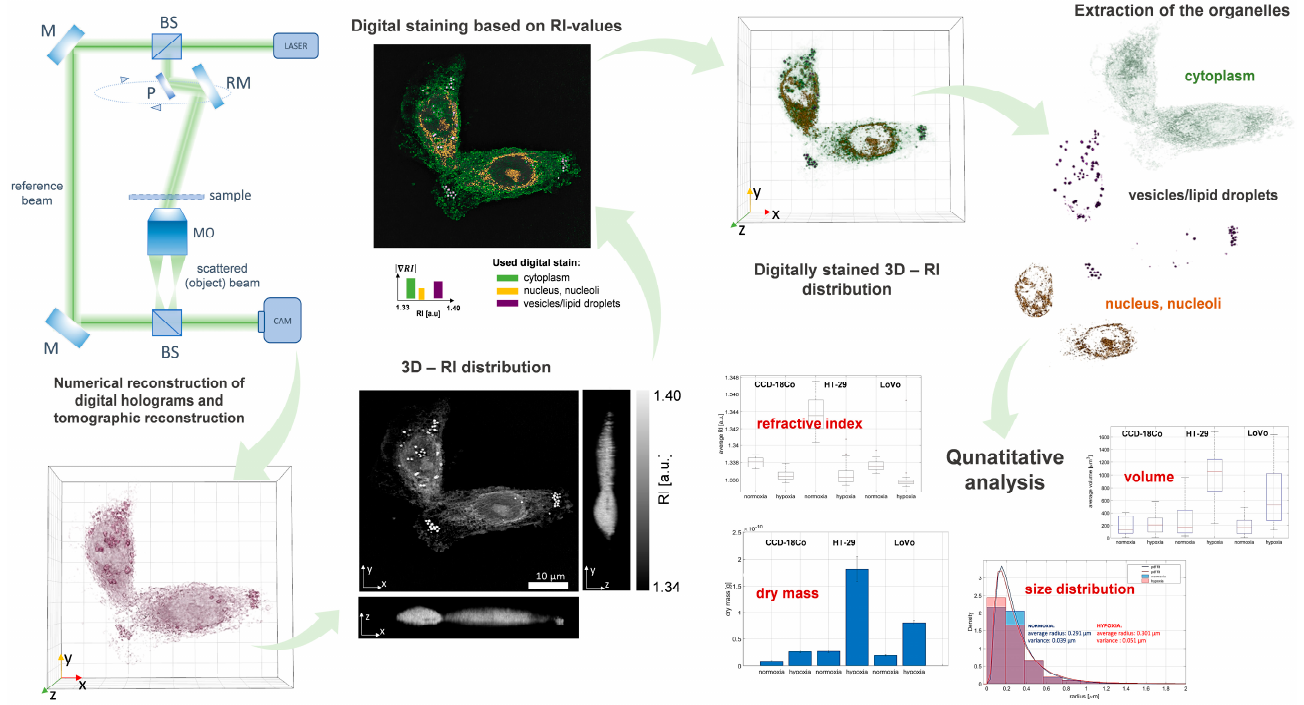
Figure 3. The schema of the DHT system (BS—beam splitters, M—mirror, RM—rotating mirror, P—prism, MO—microscopic objective) and the proposed RI data analysis algorithm.